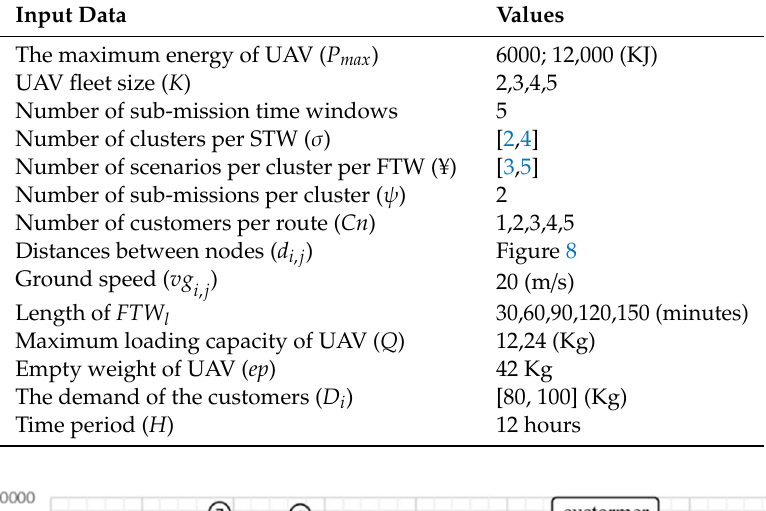
Table 2. Input data for the experiments.